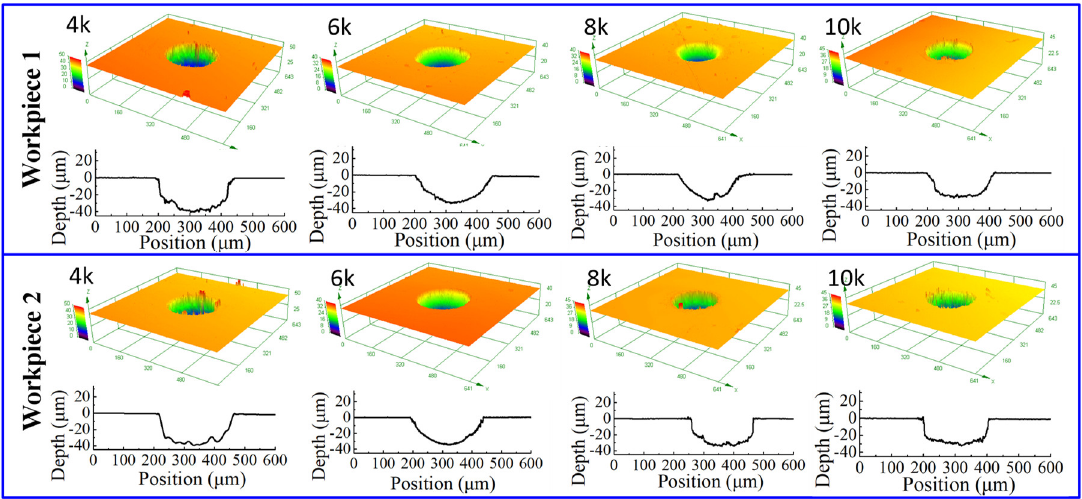
Figure 11. The 3D profile of micro dimple generated with different pulse frequencies.